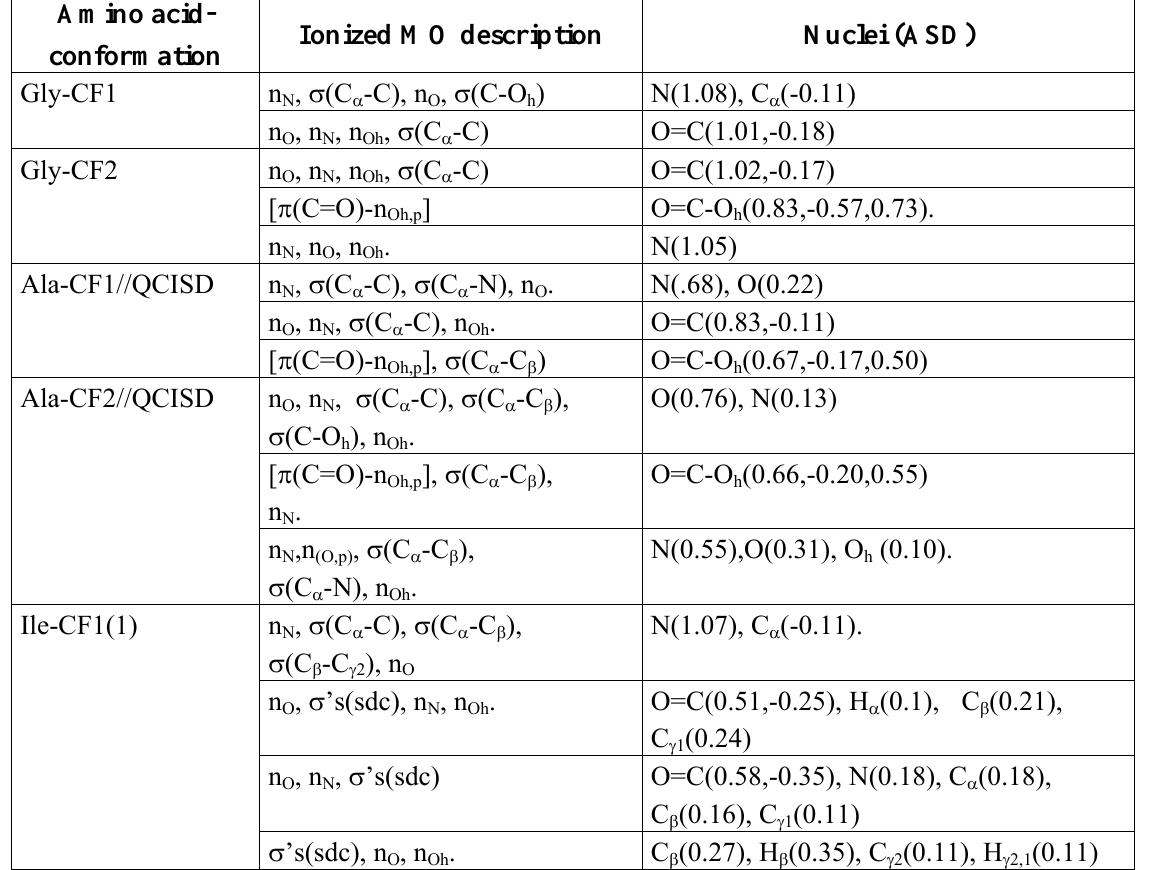
Table 5: Relation between the shape of the ionized MOs at the RHF level and the atomic spin densities (ASD) of the corresponding cations at the UHF level when obtained. Only nuclei for which the absolute value of the ASD is larger than 0.1 are listed. For Ala, ASD are calculated at the UQCISD level. The SCF convergence threshold (Th(SCF) ) was 10 on the density, unless otherwise